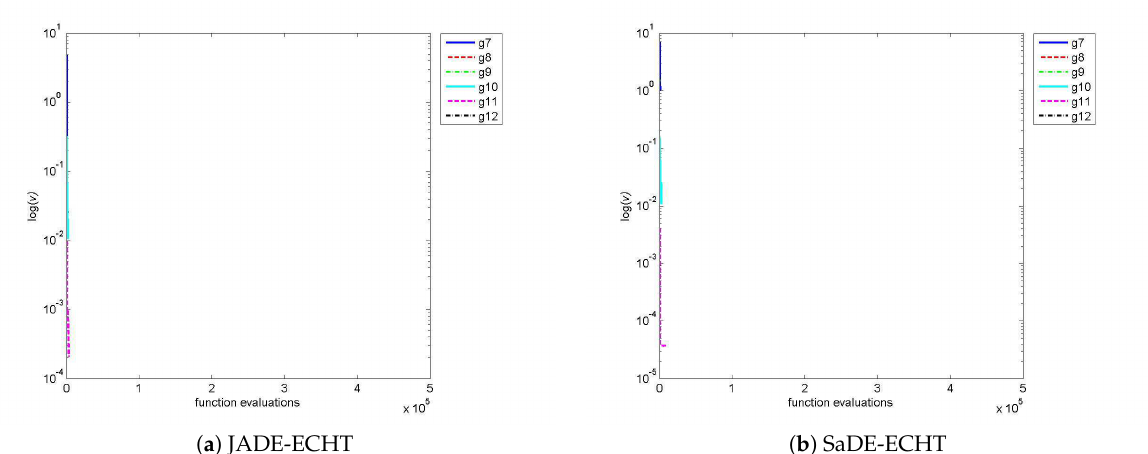
Figure 6. Constraint violation comparison of JADE-ECHT and SaDE-ECHT for g07–g12.